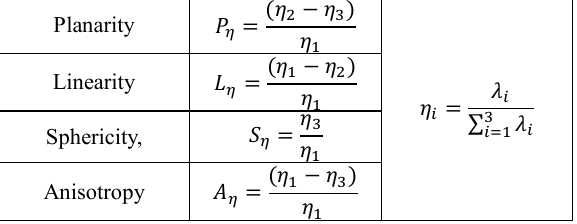
Table 1. Formula of spatial distribution feature calculation